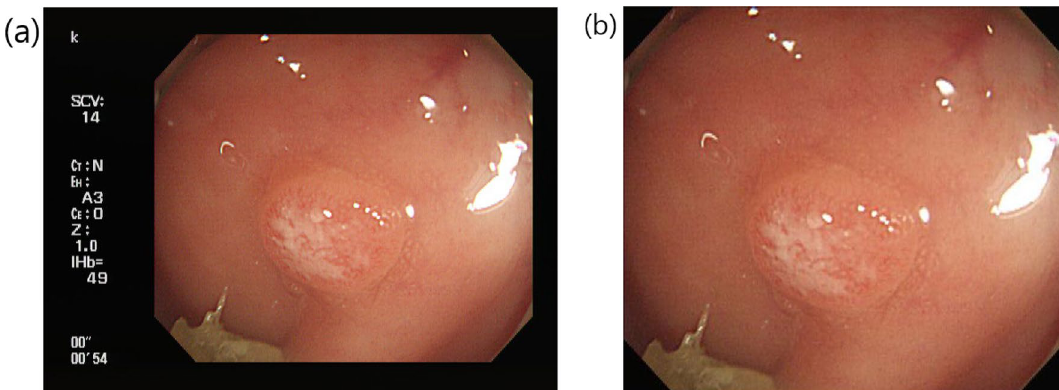
Figure 2. Original colonoscopic image ( a ) stored in the hospital Picture Archiving and Communication System (PACS) and the cropped and resized image ( b ) for training and testing our convolutional neural network- computer-aided diagnostic